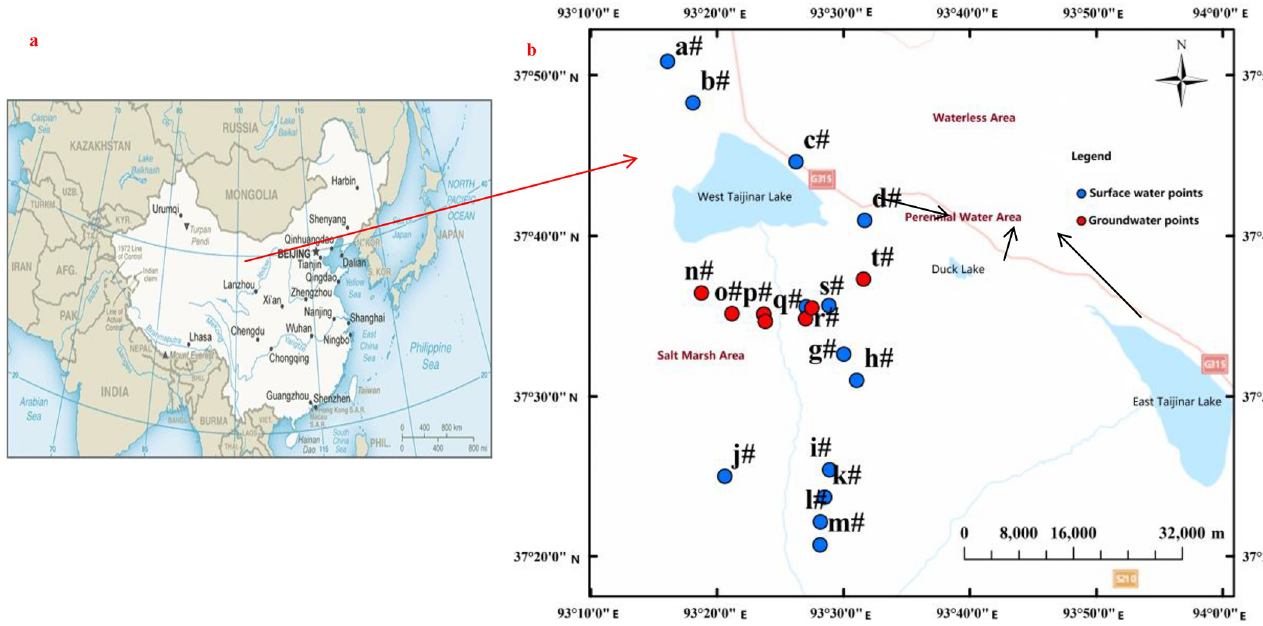
Fig 1. Geographical location of the salt marsh area and spatial distribution of the sampling points in the West Taijinar Lake, Qaidam Basin. a) reprinted from [CENTRAL INTELLIGENCE AGENCY] under a CC BY license, with permission from [CENTRAL INTELLIGENCE AGENCY], original